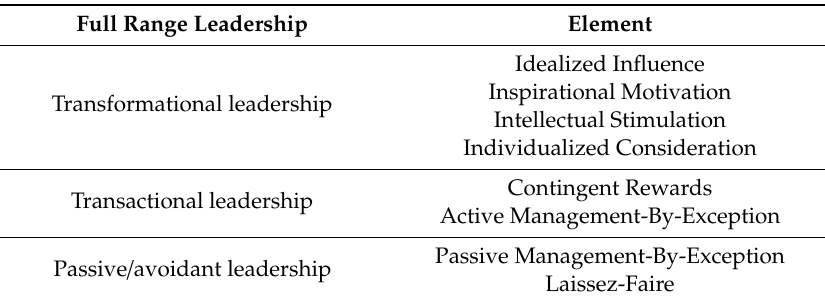
Table 1. Elements of Full Range Leadership